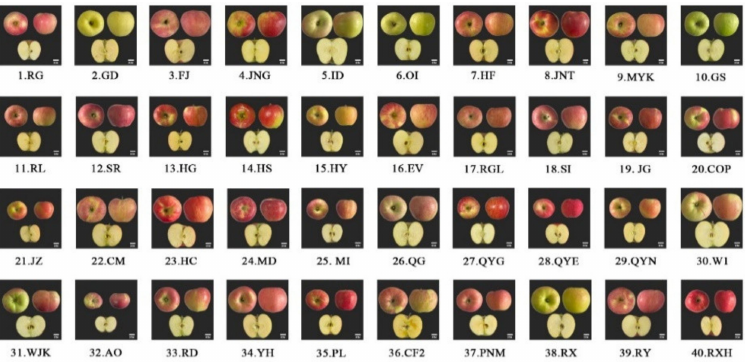
Figure 1. Materials of 40 apple cultivars used in this study. The codes refer to third column of Table 1. Bars = 2